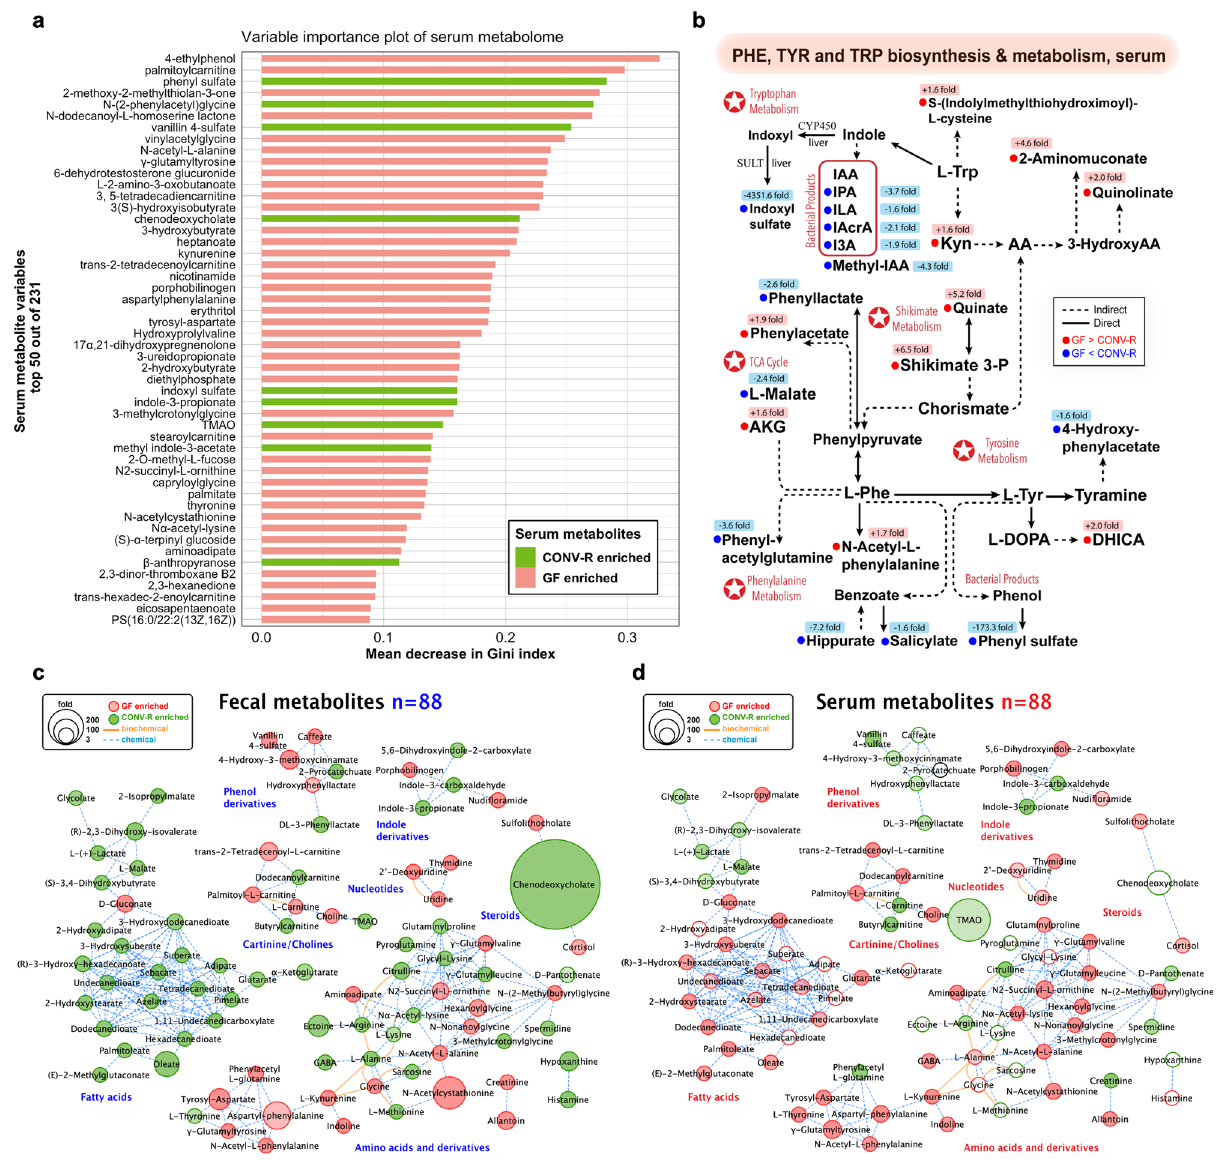
Fig. 6 Select high-impact metabolites and pathways in circulating blood and their enterohepatic transport. a Variable importance plot of top 50 serum metabolites ( y -axis) ranked by contribution to mean decrease accuracy of Gini coef fi cient ( x -axis) in the random forest model for discerning group difference. b Diagram summary of perturbed serum pathways of phenylalanine, tyrosine and tryptophan biosynthesis and metabolism. c, d MetaMapp metabolomic networks of 88 metabolite pairs altered in feces ( c ) and serum ( d ), with nodes representing individual metabolites, edges for biochemical (KEGG reactant pairs) and chemical (Tanimoto coef fi cient > 0.7) relationships, and lower transparency for lower adjusted p values (<0.05,